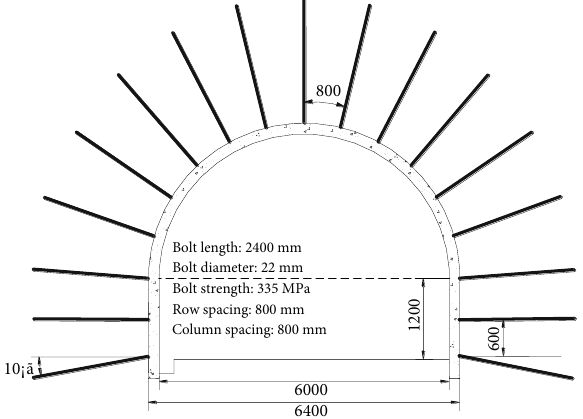
Figure 1: The supporting parameters and appearance of the roadway.